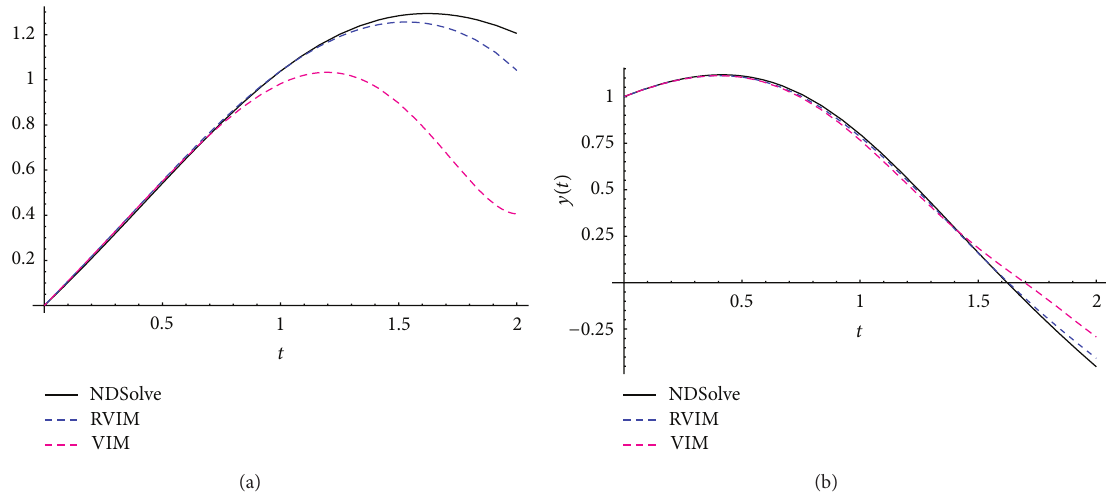
Figure 1: Simulation of the approximate results for 𝛼 = .98 and exact solution for 𝛼 = 1 of the Van der pol system.